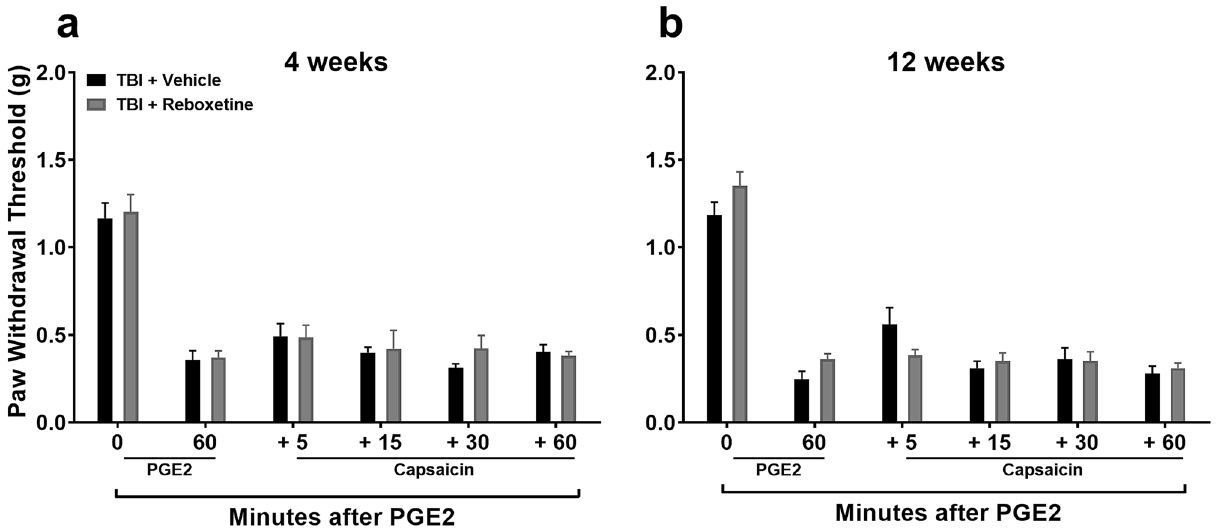
Figure 3. Assessment of diffuse noxious inhibitory control (DNIC) response after reboxetine treatment. Systemic pre-treatment with the norepinephrine reuptake inhibitor, reboxetine (RBX, 10 mg/kg, i.p. for 3 days) fails to restore the DNIC response at either 4 ( a ) or 12 ( b ) weeks post TBI in male mice. The last dose of RBX was given 18 h prior to testing to avoid acute analgesic effects of RBX on PGE 2 application. Data were analyzed by two-way repeated measures ANOVA using the Sidak multiple comparisons test to correct for multiple comparisons. Error bars: SEM, n =